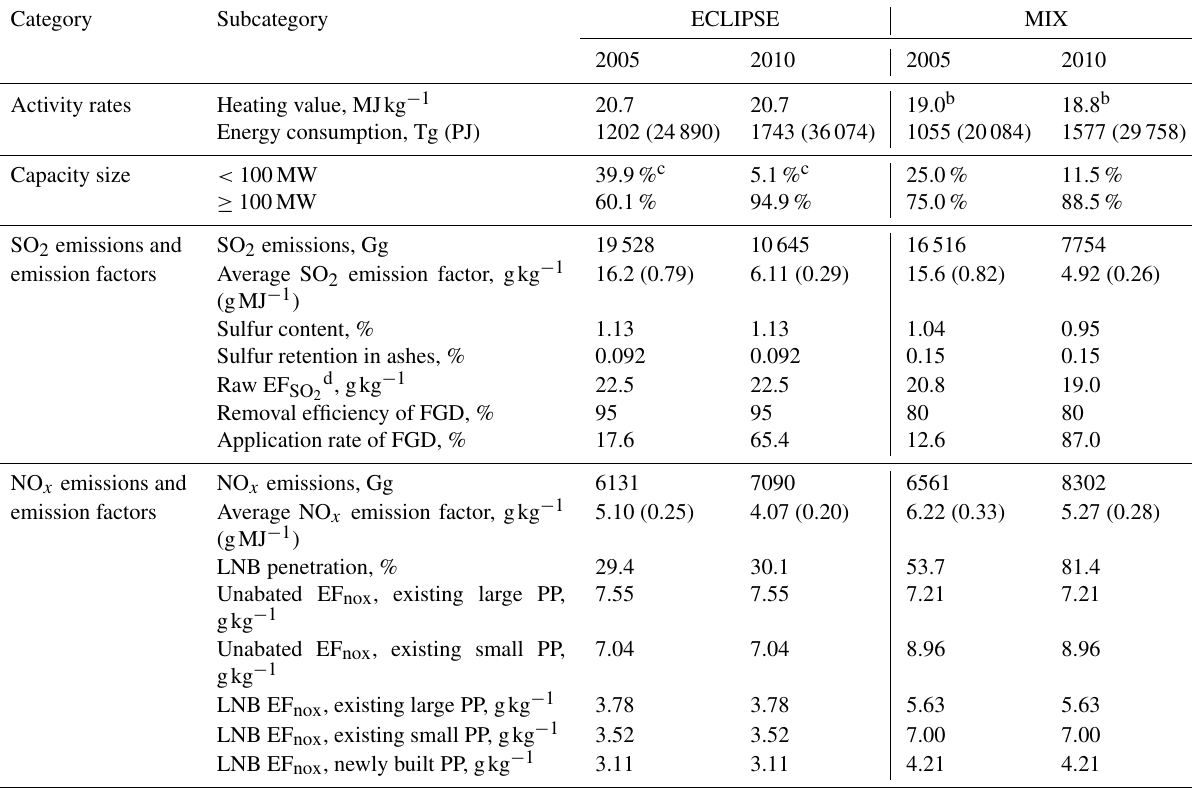
Table 2. Activity rates, emissions and emission factors for SO 2 and NO x in power plants of China for 2005 and 2010 a .